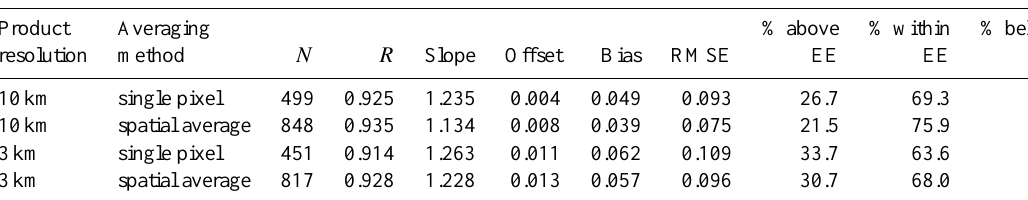
Table 1. Statistics from the 4 different MODIS/SP collocations shown in Fig. 6a,b and d–e. N =number of valid collocations, R =correlation coefficient, Slope=slope of regression line (shown in blue in Fig. 6), Offset= y intercept of the regression line, bias=MODIS average AOD minus SP average AOD, RMSE=root mean square error of collocations. EE for all cases is ± 0.05 ± 0.15AOD.